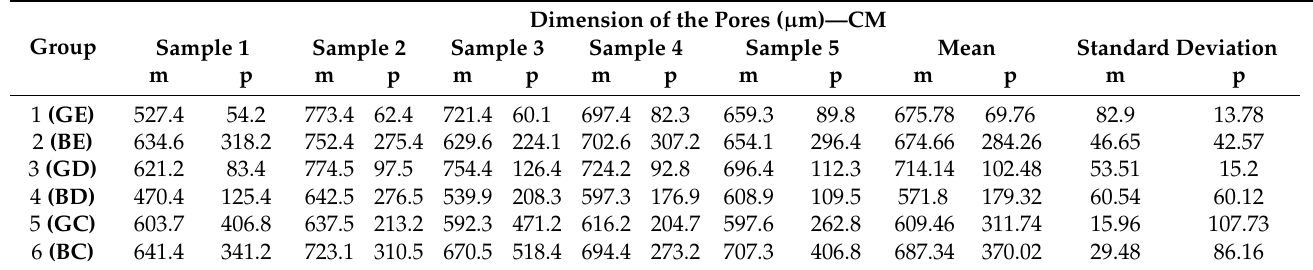
Table 3. Ascertainment of the maximum dimension of the pores ( µ m) on CM images for the two investigated areas, median (m) and peripheral (p). Dimension of the Pores ( µ